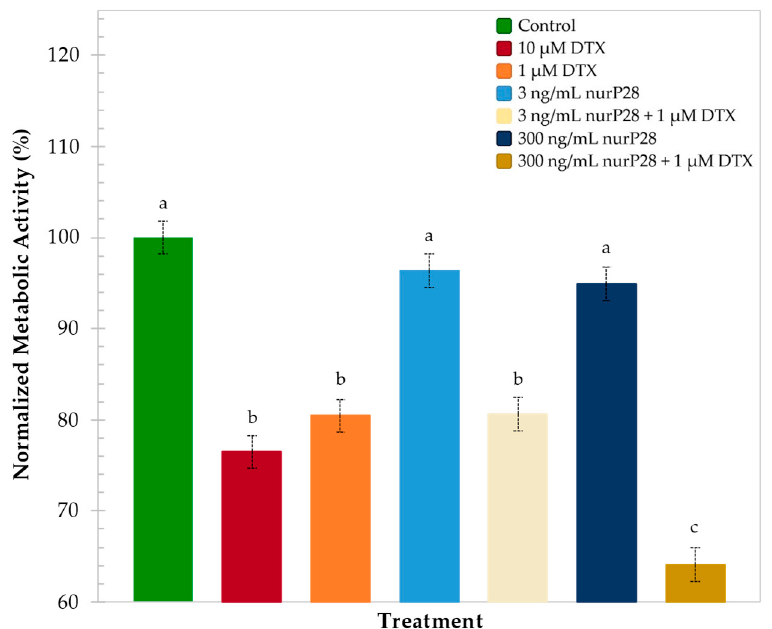
Figure 7. Normalized metabolic activity of breast cancer MCF7 spheroids after 120 h of exposure to the nurP28 peptide alone and in combination with DTX. Results expressed as mean ± SD ( n = 3). The letters a, b, and c indicate a statistically significant difference at p < 0.01. Bars with no common letters are significantly different.